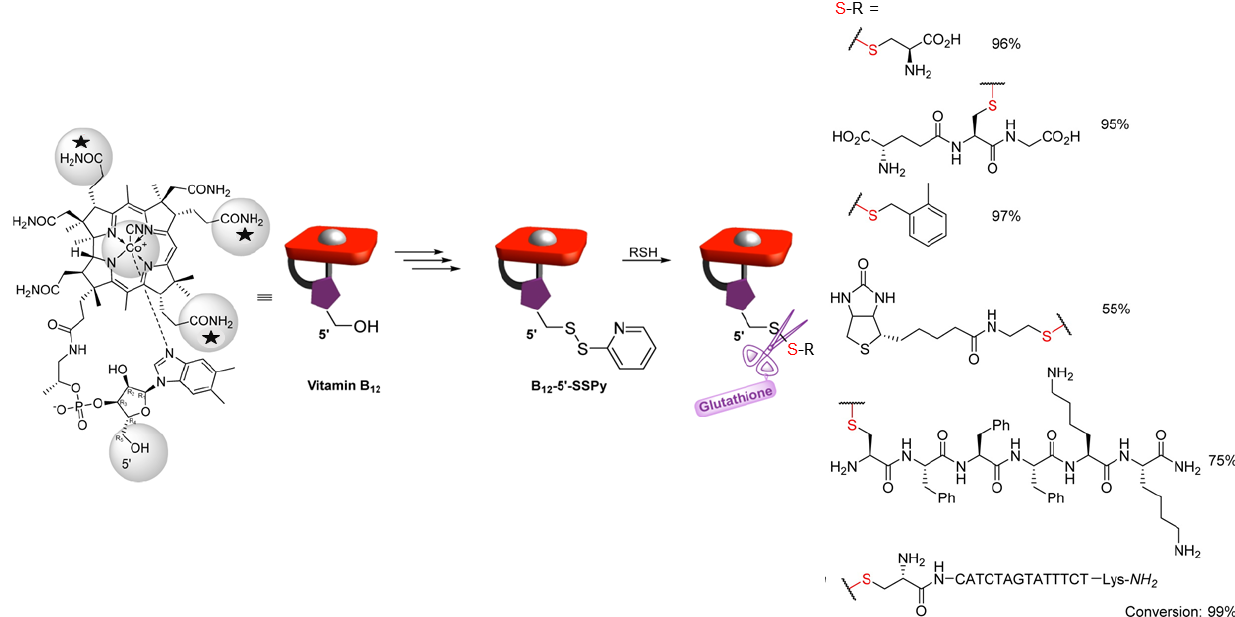
Figure 20. Synthesis of the pyridyl disulfide derivative of B 12 (B 12 -5 ′ -SSPy). Thiols were reacted with B 12 -5 ′ -SSPy to form a variety of disulfide-linked conjugates, B12-SS-R. The structure at bottom-left is a synthetic nucleic acid analog. Adapted with permission from [107]. Copyright (2016) American Chemical Society.